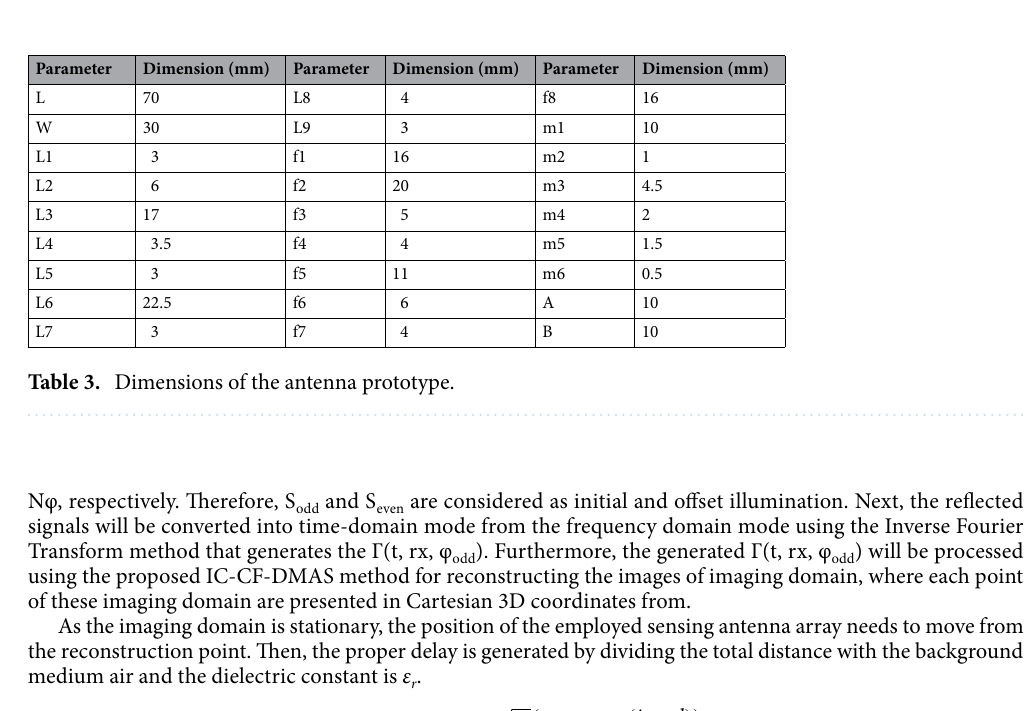
Figure 9. (a) Imaging system setup with fabricated antenna ( b ) Schematic profile of antenna and its reflection coefficient.